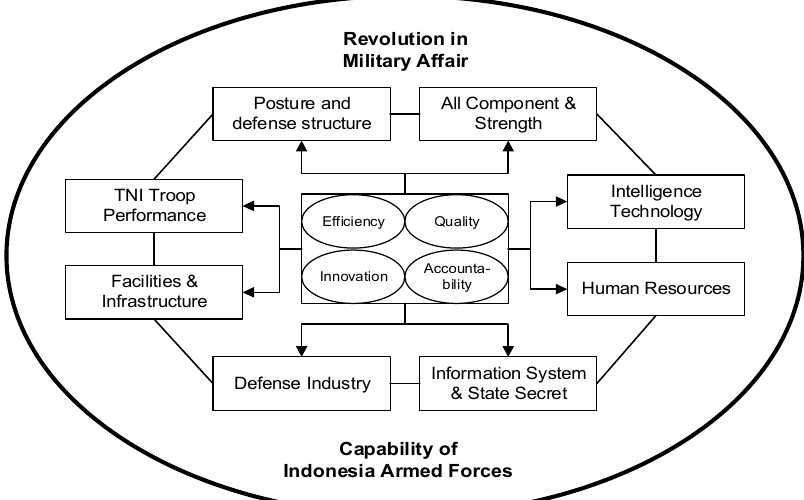
Fig. 4. Revolution in Military Affairs (RMA) Strategy Concept towards a Competitive Advantage in the South China Sea